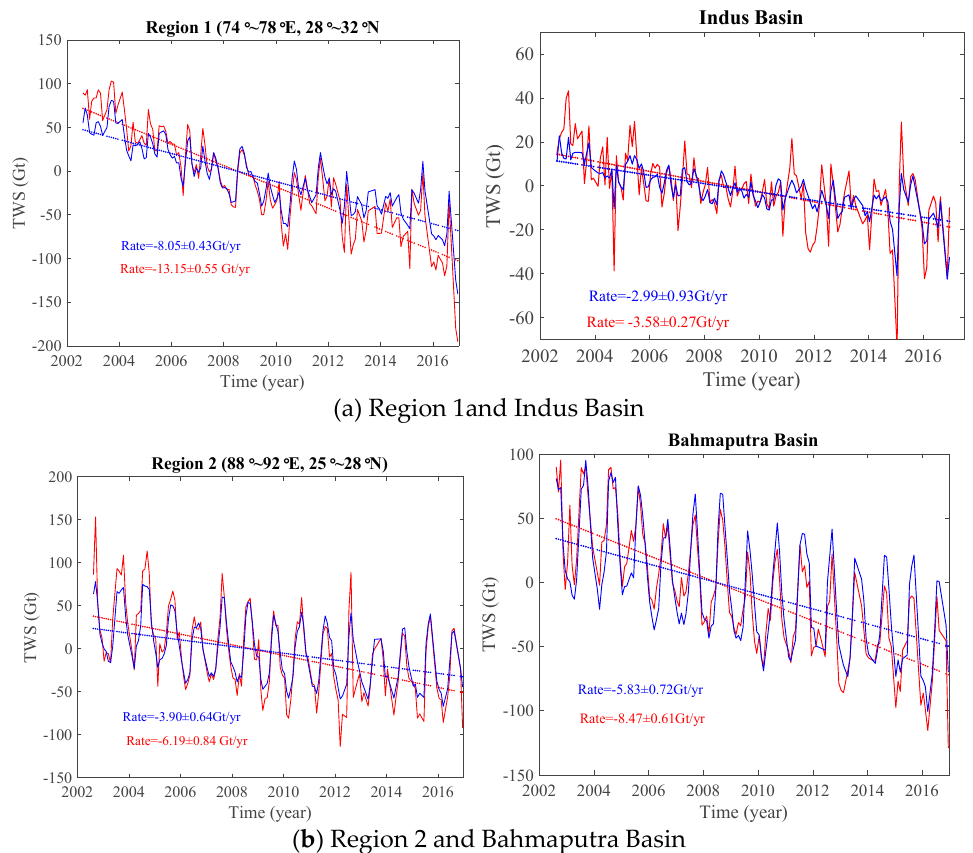
Figure 8. Time series of the water storage variations in ( a ) Region 1 (28 ◦ –32 ◦ N, 74 ◦ –78 ◦ E) (left panel) and the Indus basin (right panel) and ( b ) Region 2 (88 ◦ –92 ◦ E, 25 ◦ –28 ◦ N) (left panel) and the Brahmaputra basin (right panel) from August 2002 to December 2016. For an explanation of rates, see the legend in Figure 4.